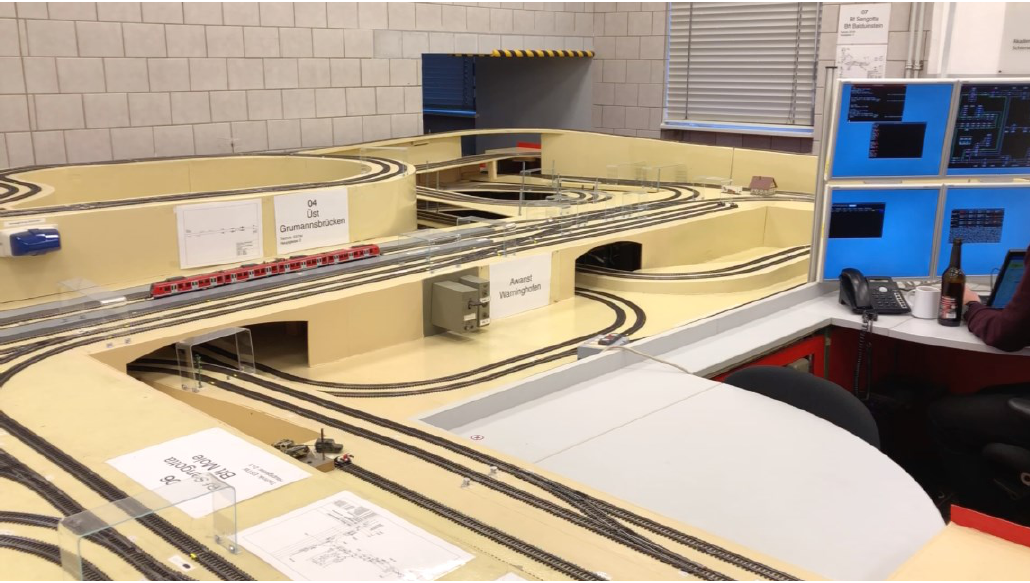
Fig. 3. EBD validation setup (excerpt of the railway